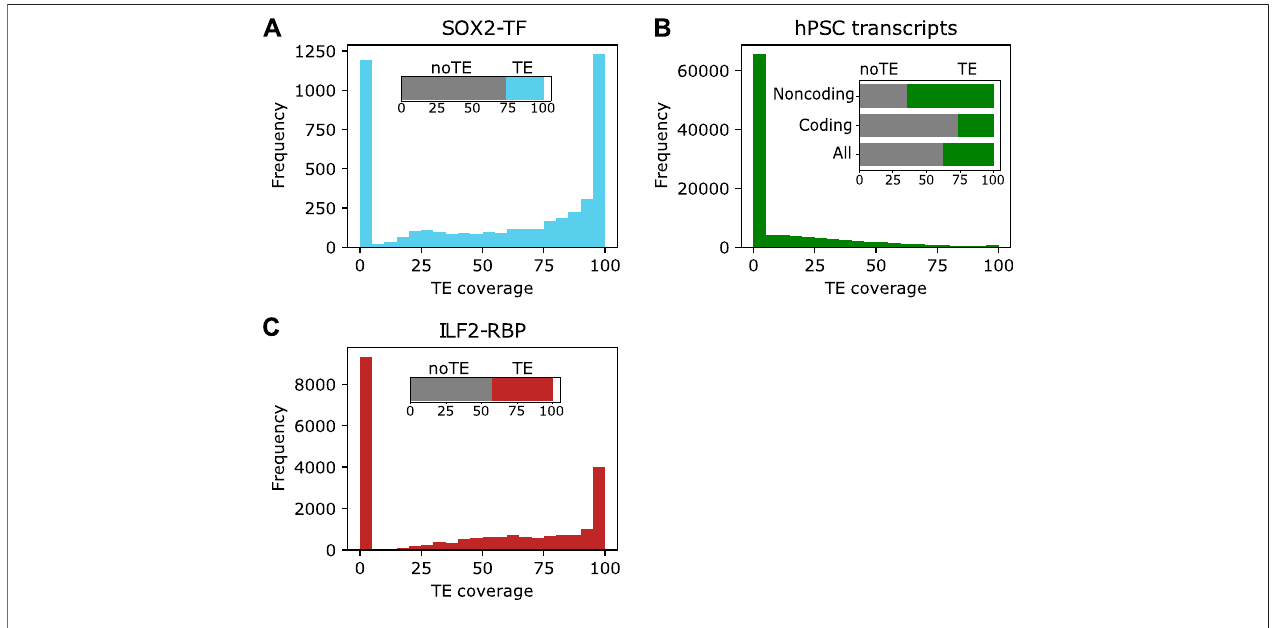
FIGURE 2 | TEs are incorporated into different elements in stem cells. (A) The distribution of TE coverage in SOX2 binding sites in human naïve PSCs. The data wereretrieved from(Huangetal.,2021). (B) ThedistributionofTEsinthehPSCtranscriptomeassembly.TheinsertshowsthedistributionofTE-sequencesinall,coding and noncoding transcripts. (C) . The distribution of TEs in ILF2 RNA binding sites. The insert is the total classi fi cation based on any TE